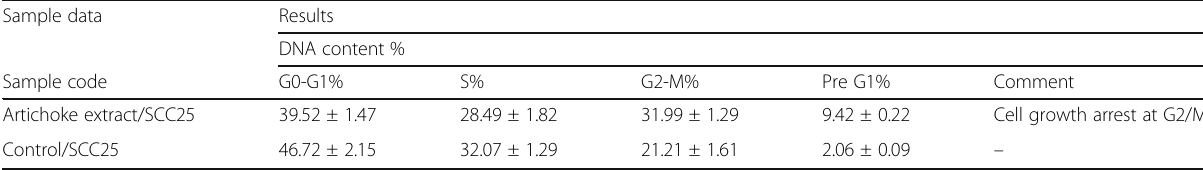
Table 5 Percentage of DNA content during phases of the cell cycle in control and artichoke extract/SCC25 using paired Student ’ s t test and variability of measures